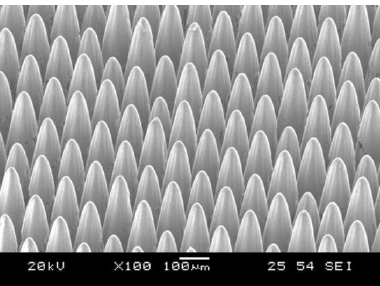
Figure 5. Micro-pins array fabricated on stainless steel sheet (AISI 304, 3 mm × 3 mm) by the pro- cess of LBM [15].